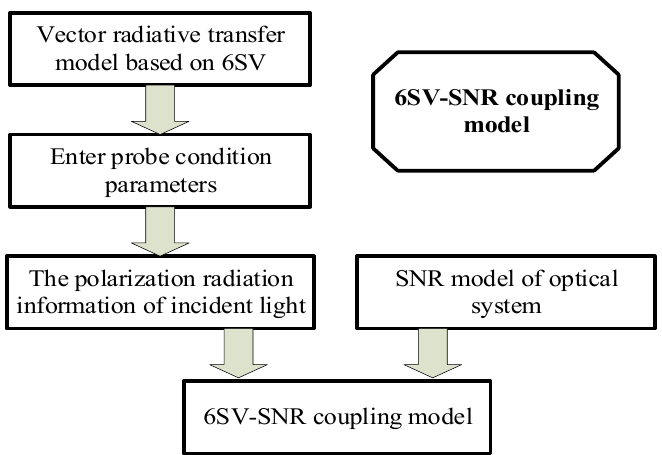
Figure 2. Coupling modeling process of the 6SV–SNR (Firstly, the parameters are input into the vector radiative transfer model based on 6SV to obtain the polarization radiation information of incident light. Secondly, the SNR model of optical remote sensor is established. Finally, the SNR of the optical remote sensor can be obtained by substituting the polarization radiation information of the incident light into the SNR model).